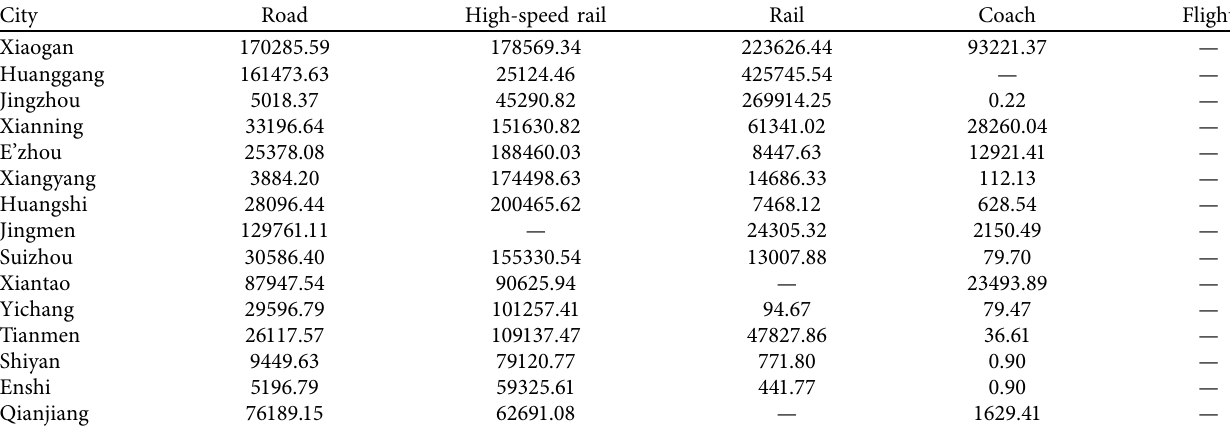
Table 10: Mode flow distribution results of cities inside the province of Hubei. City Road